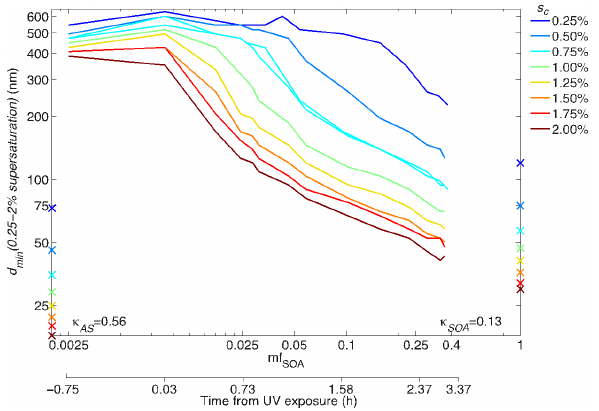
Figure 5. Comparison of the two measurement techniques continuous-flow streamwise thermal-gradient CCNC (CFSTGC, or- ange) and Scanning Flow CCN Analysis (SFCA, blue, red and green) with error bars (black) representing 95% confidence inter- vals, from experiments DEP1 and DEP2 respectively. The change in s c over time for diesel exhaust particles is captured in both ex- periments, though with a better resolution while using SFCA. A slower decrease of s c is seen in DEP2 (SFCA) due to altered ex- perimental conditions, with a slower ageing process. During DEP2 the temperature gradient ( 1T ) was changed three times (4K, blue; 10K, red; and 18K, green). Note that the first measurement point using CFSTGC was possible due to letting the experiment scan past a constant supersaturation and d m (see Sect. 2.1 for more informa-